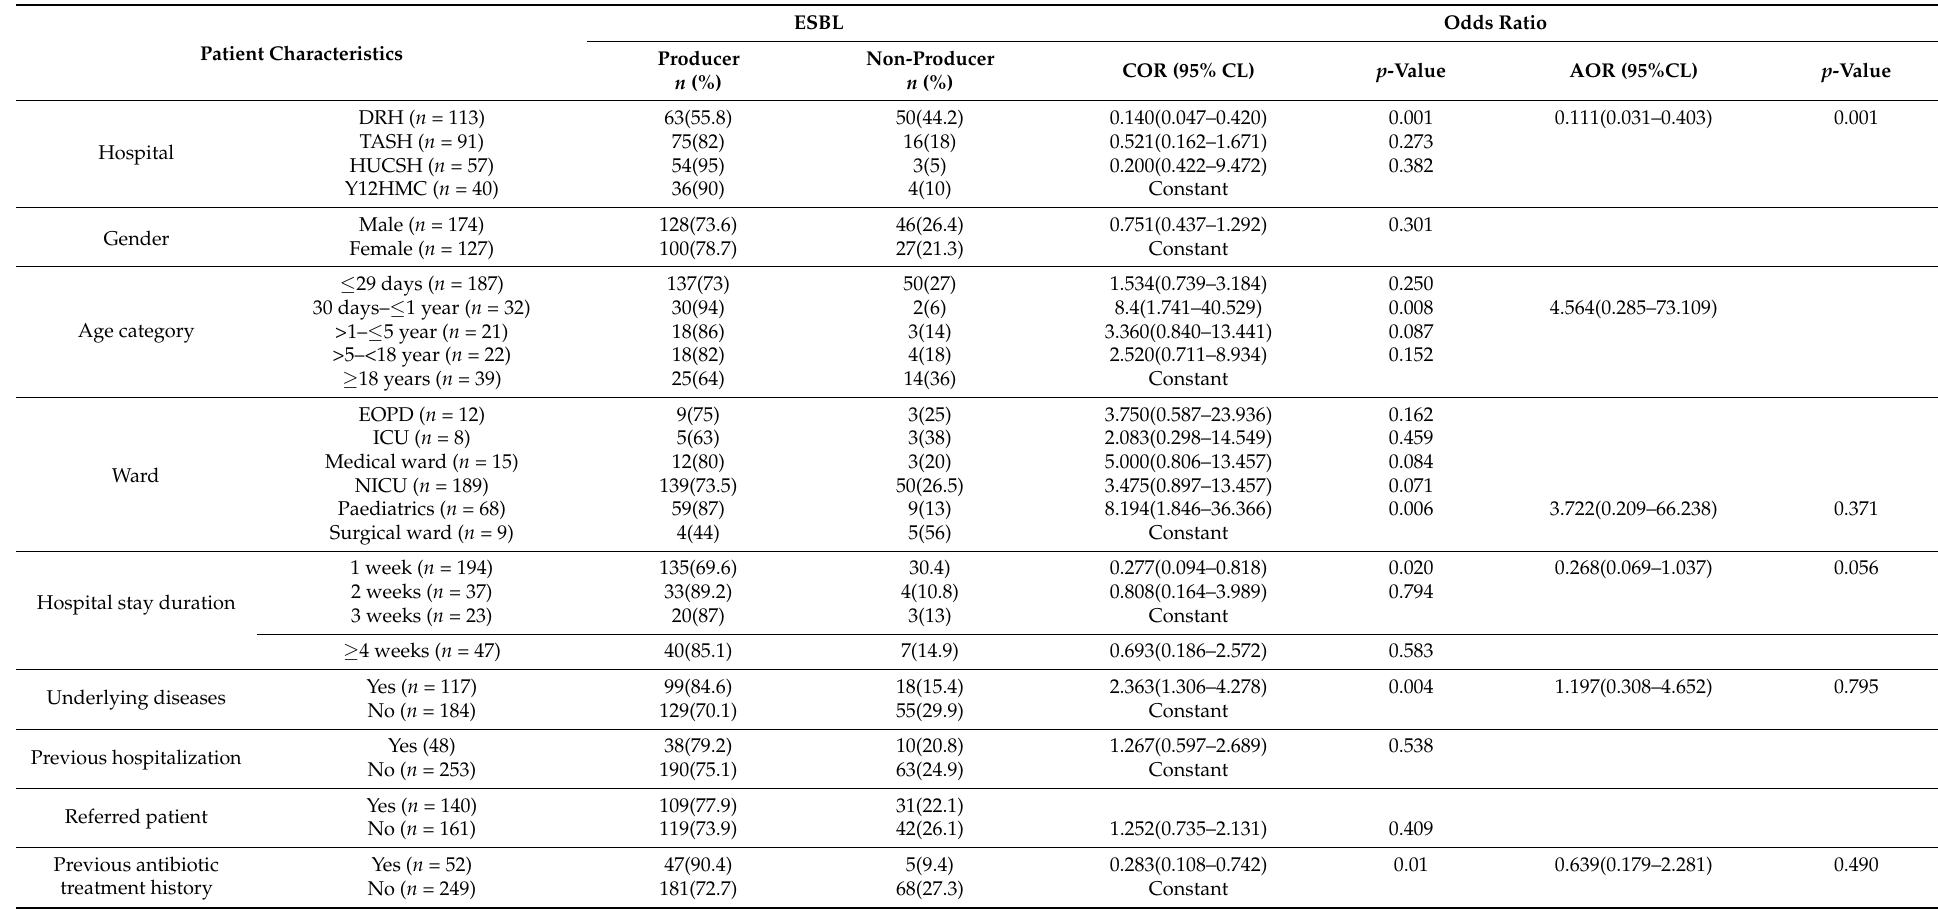
Table 3. Frequency of Enterobacteriaceae that harbored at least one ESBL gene in relation to patient